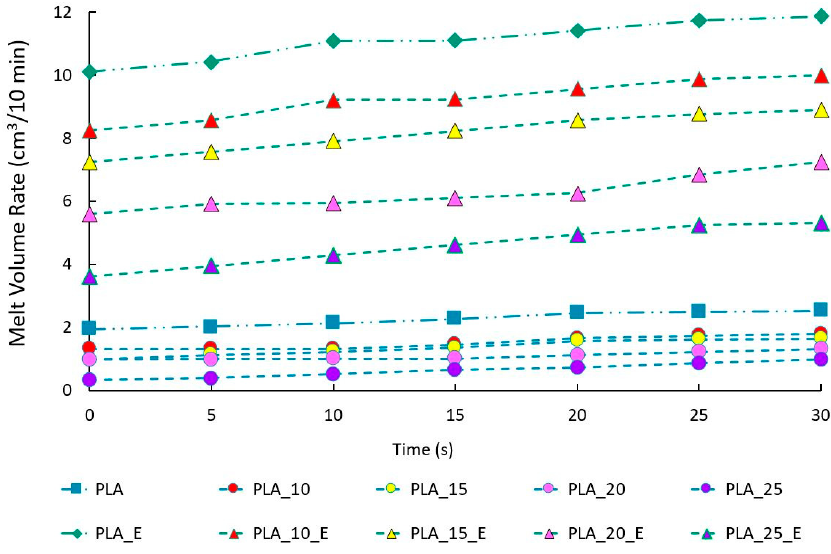
Figure 9. MVR trends for PLA / Arbocel composites with and without